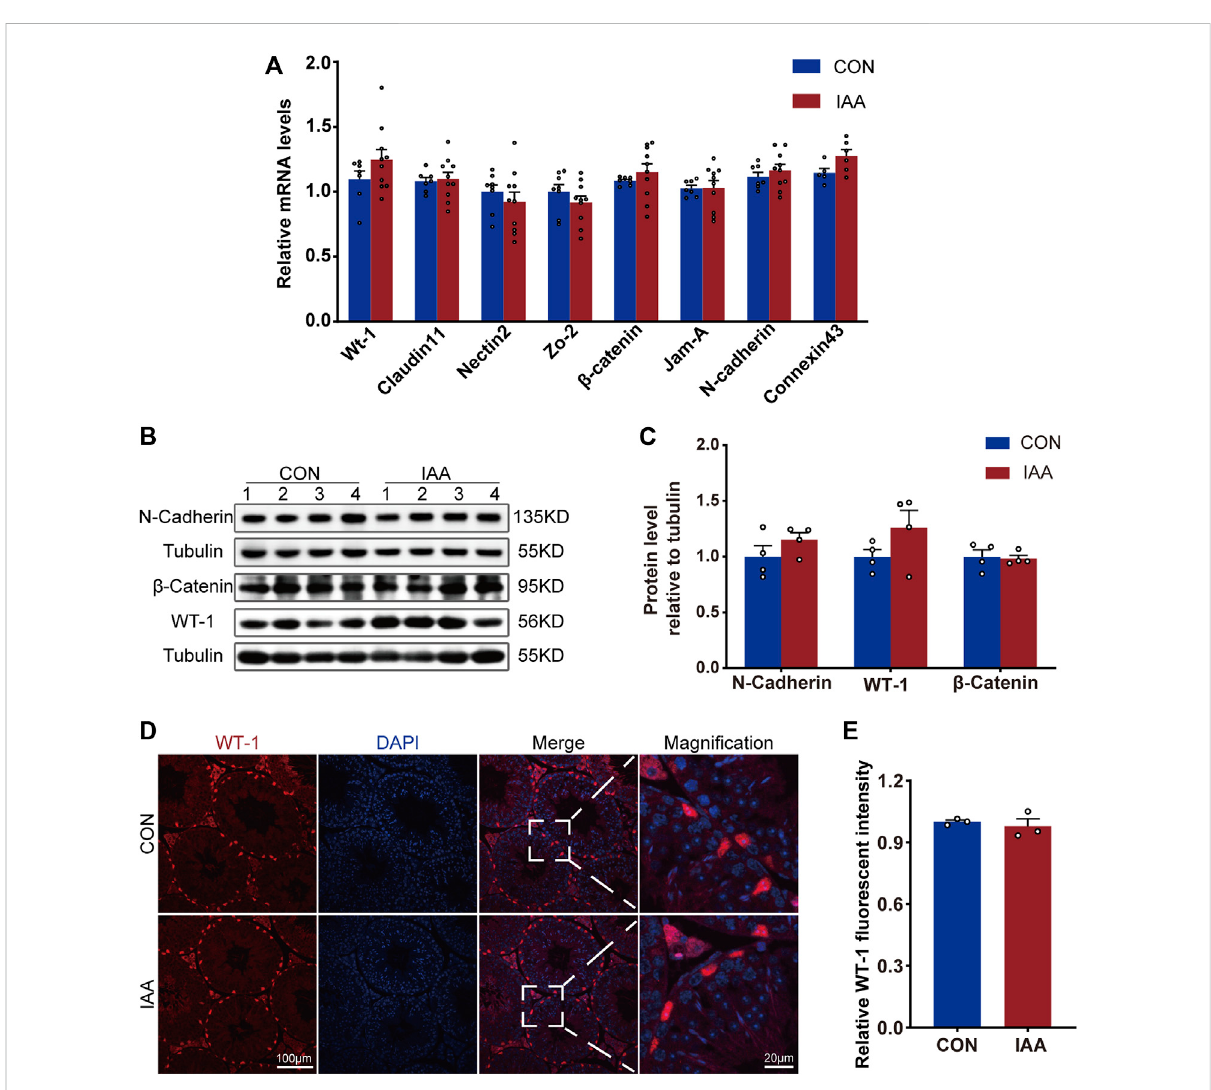
Changes of BTB-related indexes were detected from gene expression and protein level. Relative mRNA levels between the two groups, Wt-1, Claudin-11, Nectin-2, Zo-2, β -catenin, Jam-A, N-cadherin and Connexin-43, were observed (A) . The protein levels of WT-1, N-cadherin, and β - catenin were also observed by Western Blot (B,C) and immuno fl uorescence staining experiments (D,E) . * Signi fi cant differences compared to the control ( p <